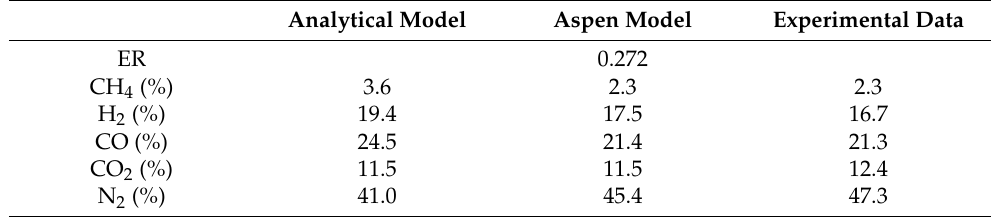
Table 5. Comparison of syngas mole fraction composition between the results of analytical and As- pen models and experimental data reported in [36].